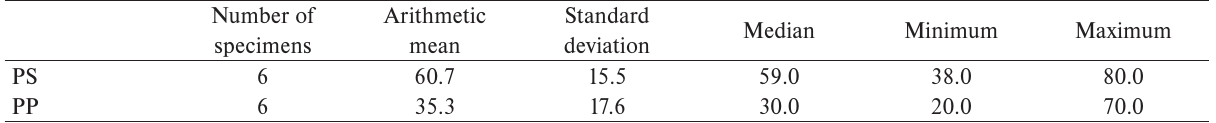
Table 6. Descriptive statistical data for bending stiffness in loading option